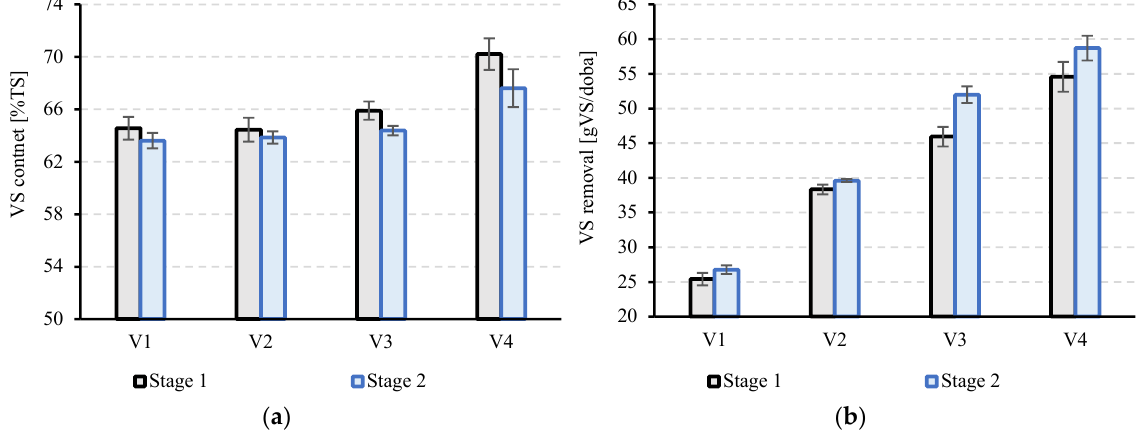
Figure 5. VS percentage in dry mass ( a ) and VS removal ( b ) across experimental variants. The digestion coefficient/portion digested ( η F ) decreased as the OLR increased in successive experimental variants (Table 3). In S1, η F peaked in V1 and V2 at 64.21 ± 1.2% and 64.57 ± 0.8%, respectively (Table 3). Subsequent variants of this stage showed a notable decline in η F , with rates of 58.25 ± 1.0% in V3 and only 44.88 ± 0.8% in V4 (Table 3). On the other hand, S2 was characterized by higher η F across all variants, ranging from 65.85 ± 1.3% in V3 to 67.75 ± 1.1% in V1 (Table 3). V4, however, marked a significant decrease in η F , which fell to 50.87 ± 0.9% (Table 3).